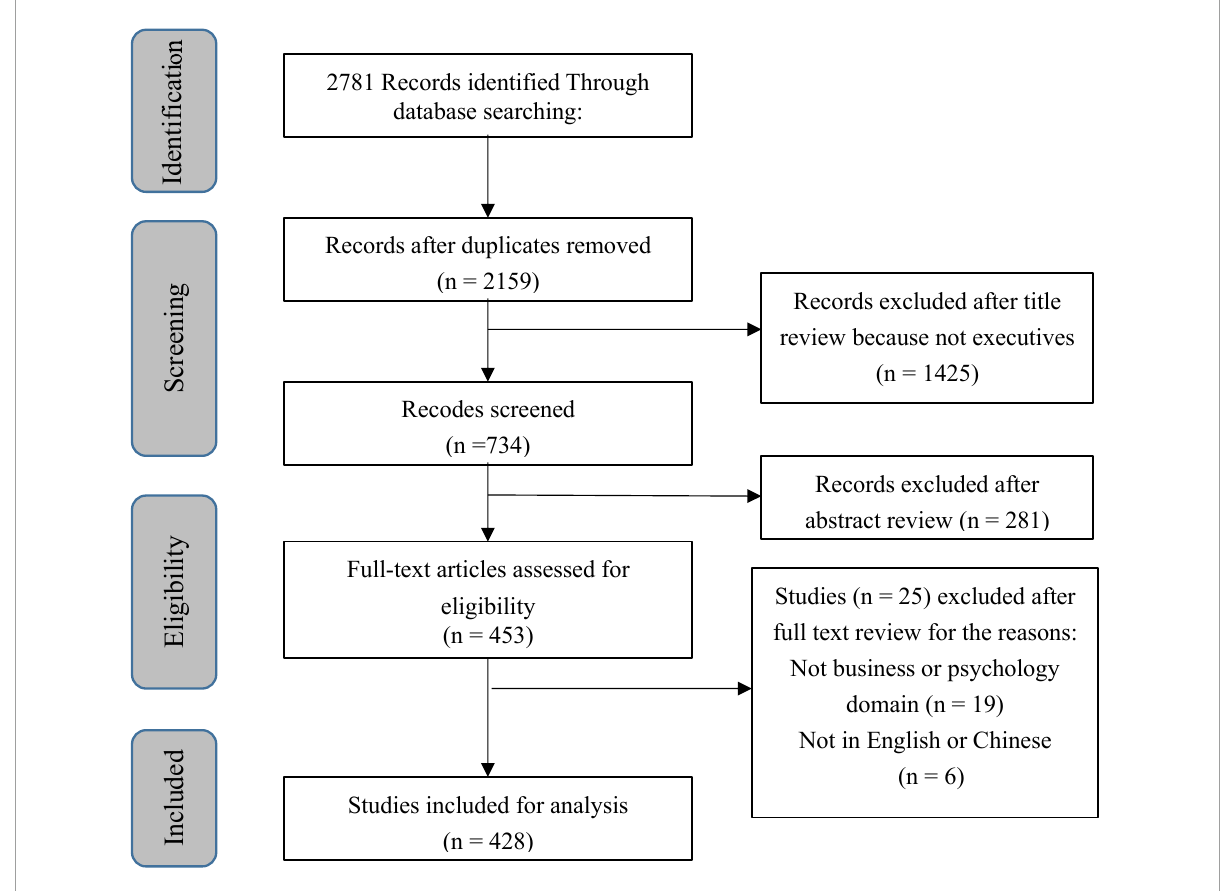
FIGURE1 The workflow of systematic literature review (SLR).